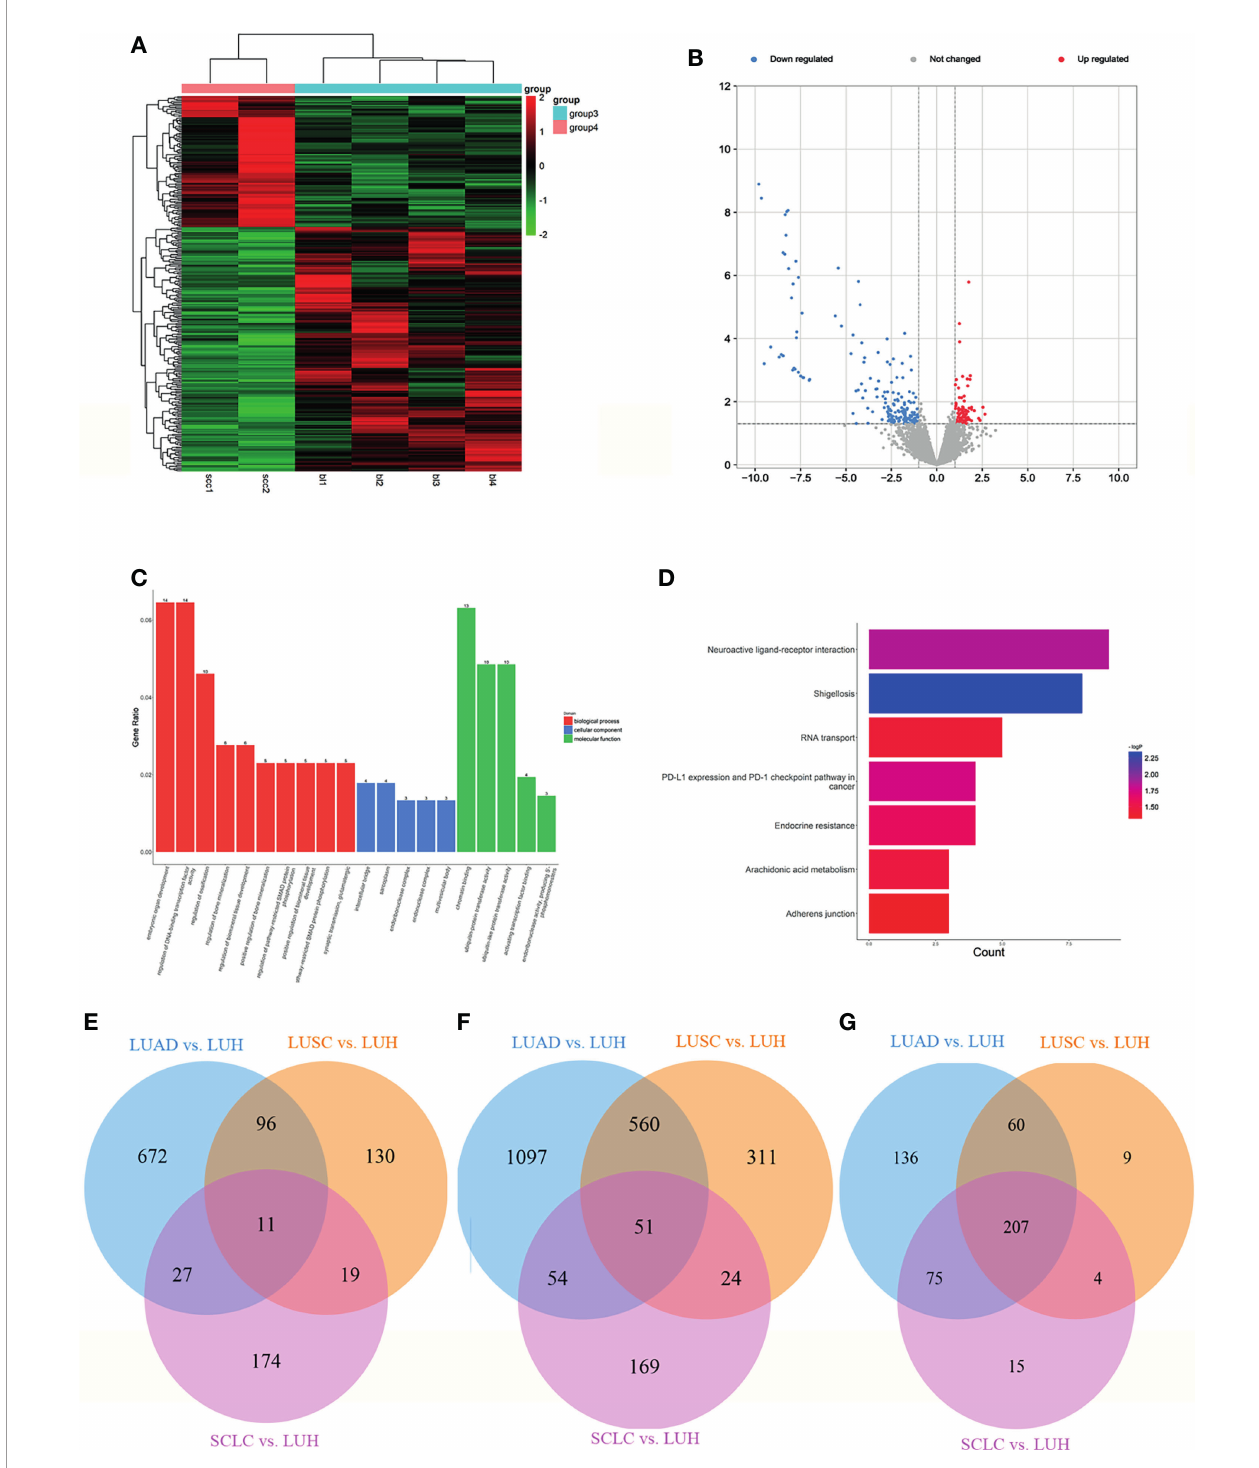
FIGURE 6 | Expression pro fi les of lncRNAs in plasma between SCLC patients and negative controls. (A) Heatmap of differentially expressed lncRNAs in SCLC patients and LUH patients (group 4, SCLC plasma; group 3, LUH plasma). (B) Volcano plot of differentially expressed lncRNAs. (C) Enrichment analysis of GO terms and pathways of the differentially expressed lncRNAs. (D) KEGG pathway analysis of the differentially expressed mRNAs between two groups. Venn diagram showed the common signi fi cant mRNAs (E) , lncRNAs (F) , and canonical pathways (G) in three groups (LUAD, lung adenocarcinoma; LUSC, lung squamous cell carcinoma; SCLC, lung small cell cancer; LUH, lung